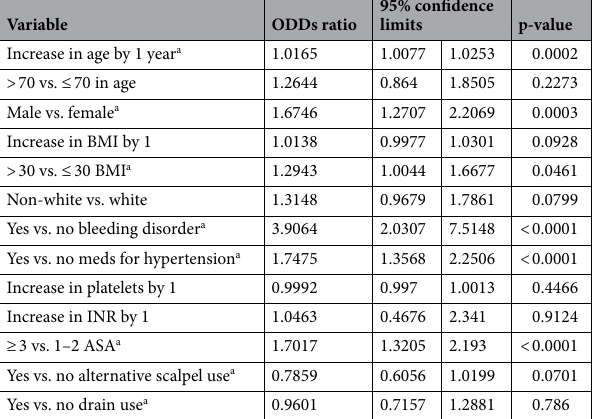
Table 3. Results of all variables by univariate analysis for post-operative hematoma. a Indicates variables carried forward to the multivariable